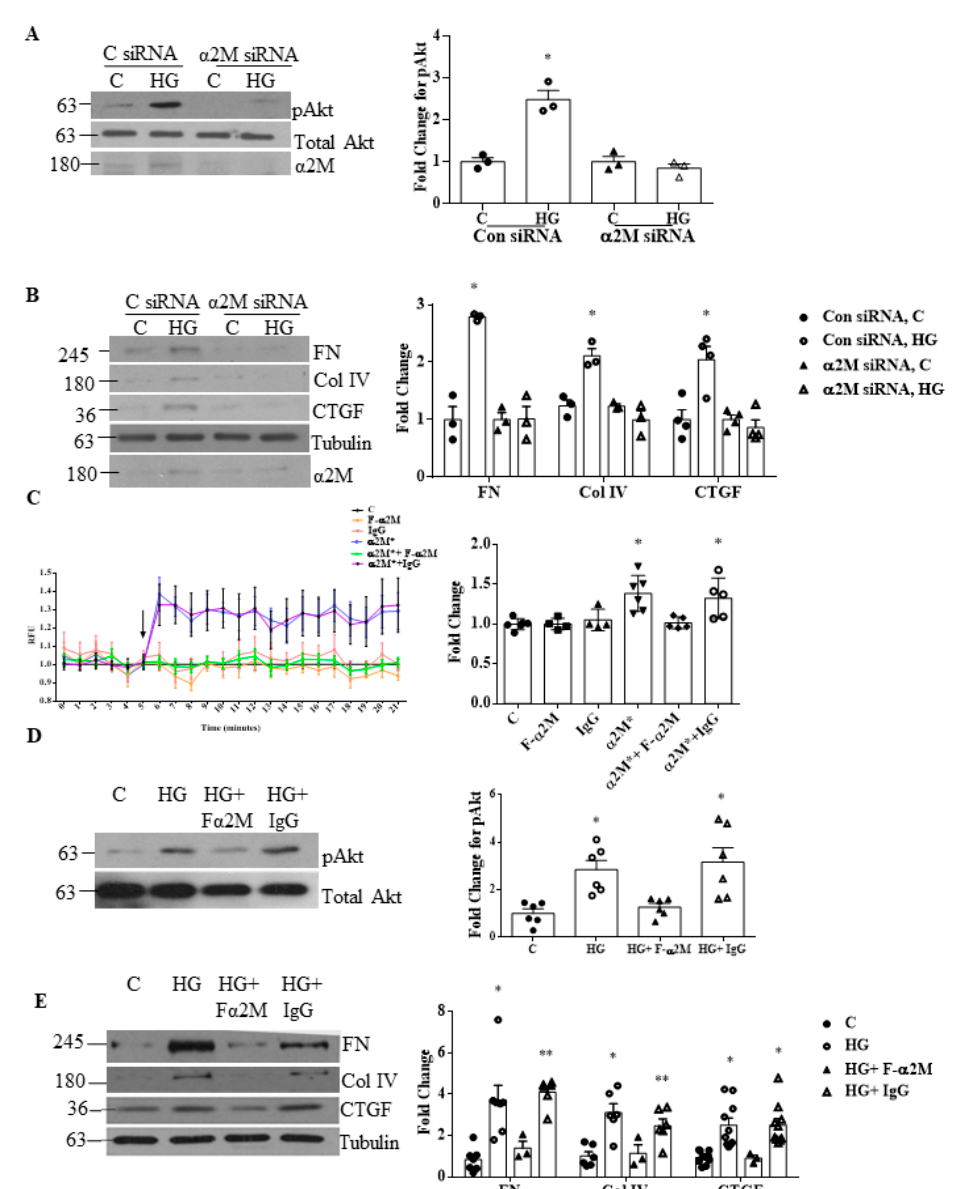
Figure 3. α 2M knockdown or neutralization inhibits HG-induced Akt activation and downstream ECM accumulation. ( A , B ) Immunoblotting shows that α 2M siRNA inhibited upregulation of fibronectin (FN), collagen (Col) IV, the cytokine CTGF, and Akt activation (pAkt on S473) compared to control siRNA in response to high glucose (HG, 48 h, n = 5) (* p < 0.01 vs. all others in the individual group). ( C ) Fura 2-AM calcium assay in 1-LN cells shows that the increased release of intracellular calcium stores in response to α 2M* (100 pM, 15 min) was inhibited with addition of the neutralizing antibody F α 2M (2 μ g/mL) but not control IgG. Groups were compared at one minute after time of treatment, which is indicated by the arrow ( n = 6, * p < 0.01 or ** p < 0.05). ( D , E ) Antibody neutralization of α 2M* abrogated high glucose (HG, 48 h)-induced FN, Col IV, and CTGF protein upregulation and Akt activation (pAkt on S473) compared with nonspecific IgG ( n = 11) (* p < 0.01 or ** p < 0.05 vs. con and HG + F α